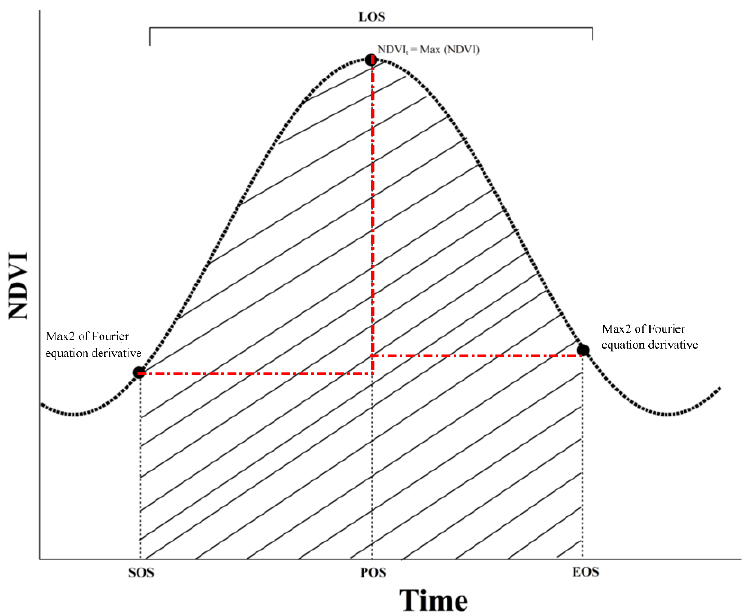
Figure 2. Illustration of the normalized difference plant index (NDVI) ratio method used to model the growing season (SOS), peak of the growing season (POS), end of the growing season (EOS), and length of the growing season